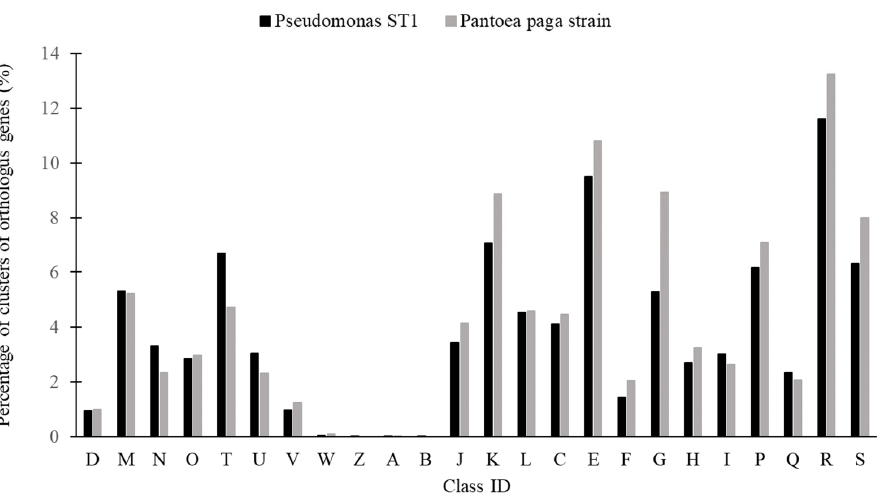
Figure 6. Percentage of clusters of orthologus genes (%) in Pseudomonas ST1 strain and Pantoea paga strain. Letters on the x ‐ axis correspond to different groups of functional genes: D—cell cycle control, cell division, chromosome partitioning; M—cell wall/membrane/envelope biogenesis; N—cell mo ‐